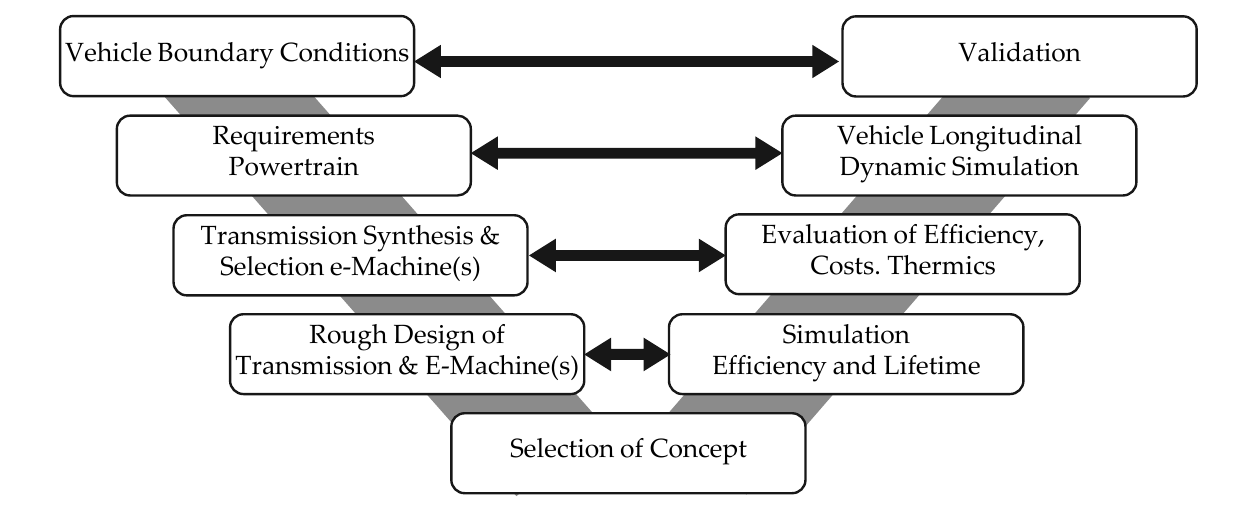
Figure 1. V-model of the ika design methodology for electric powertrains.